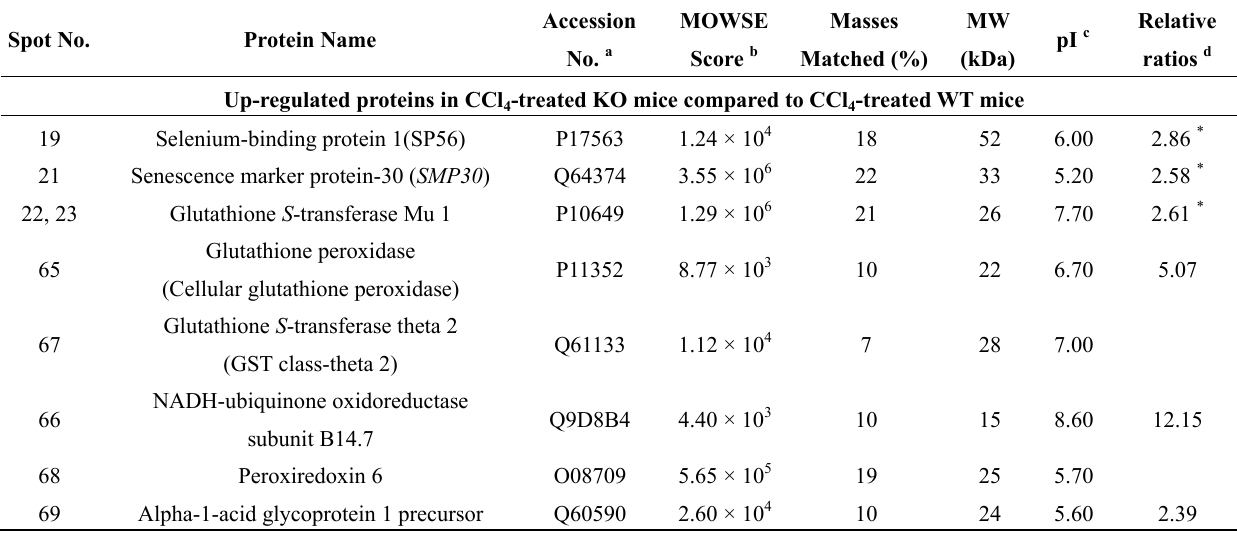
Figure 4. Expression of p- Smad3 in the SMP30 Y/ − mice. Immunohistopathological detection of p- Smad3 in liver tissues from ( A ) SMP30 Y/+ ; ( B ) CCl -treated SMP30 Y/ − mice. Cont indicates the ( C ) SMP30 Y/ − ; and ( D ) CCl 4